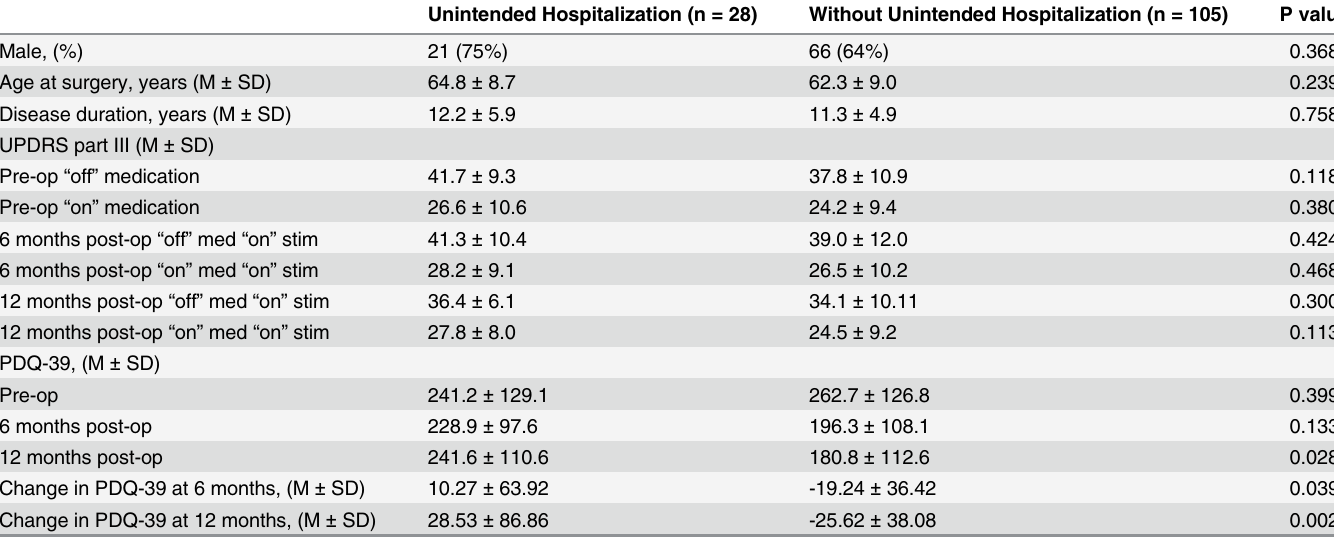
Table 2. Demographic and Clinical Characteristics of Patients (n = 133).